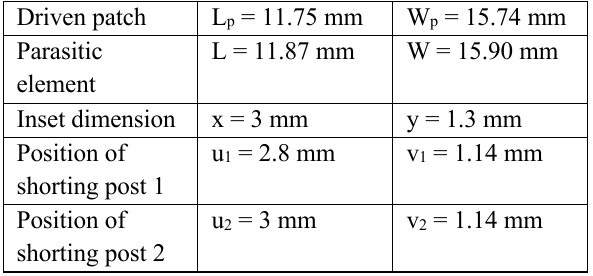
FIGURE 1. (a) Front, and (b) Back view of the proposed PRPA.